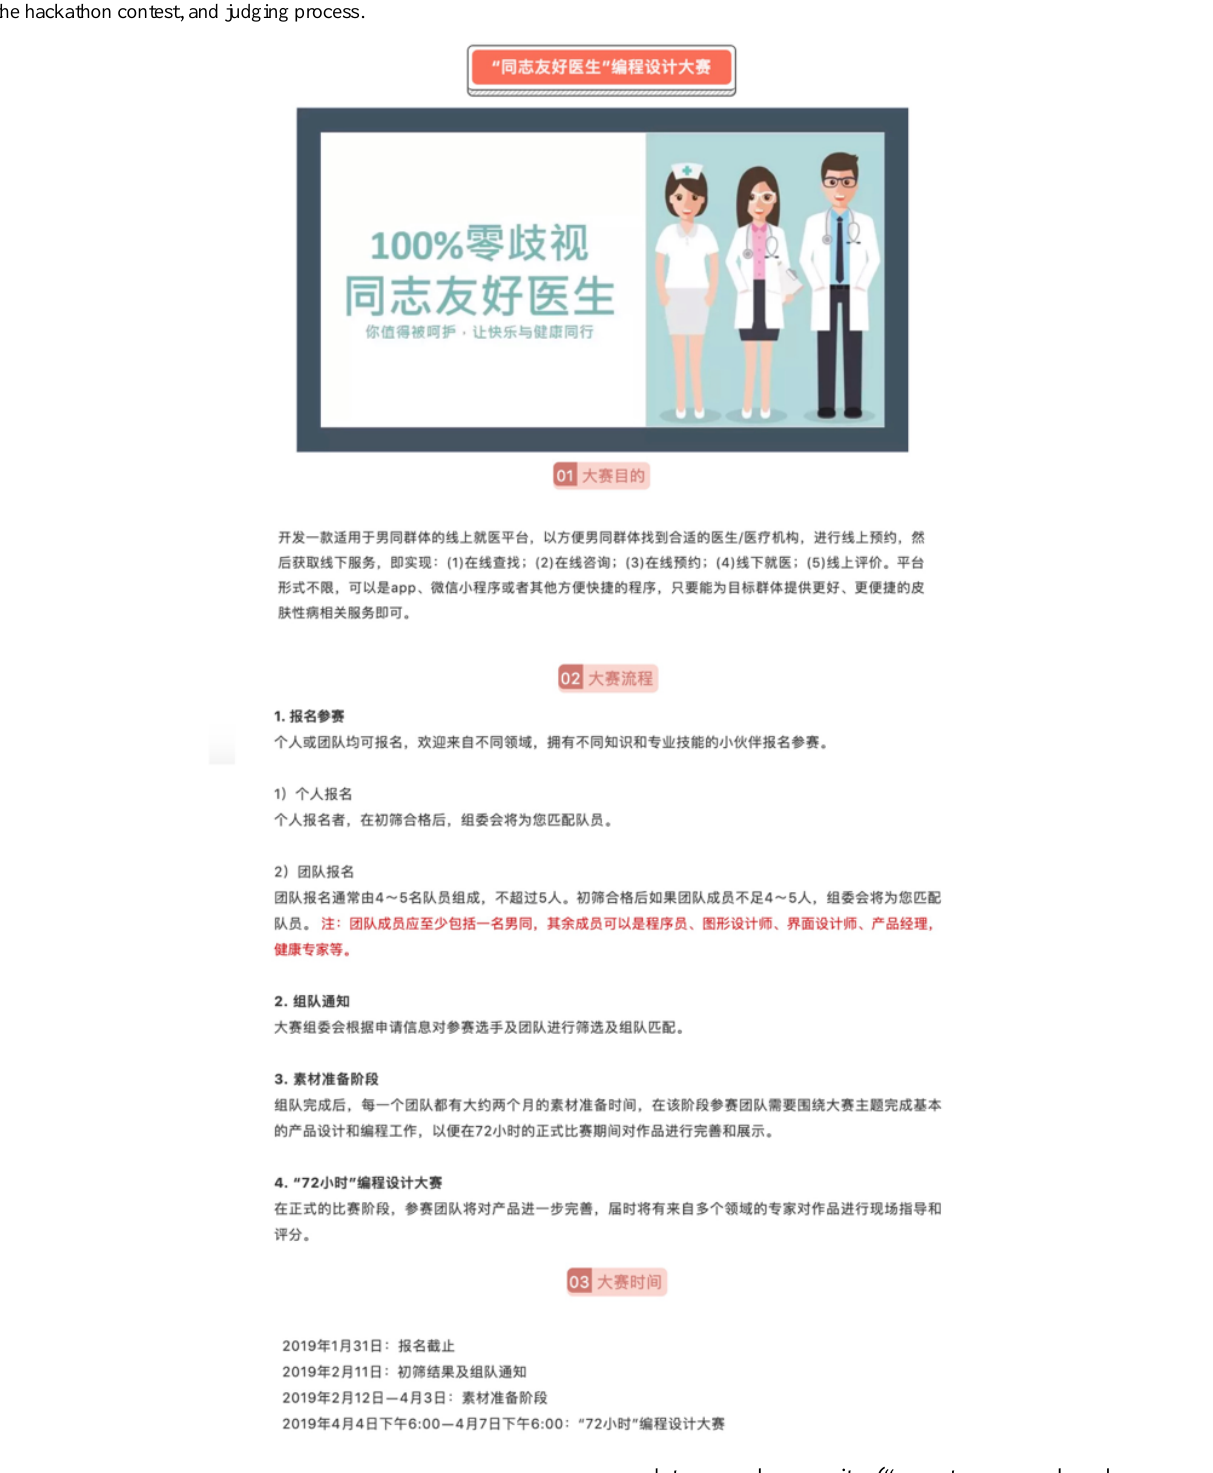
Figure 1. A screenshot of the call for applicants (advertised on Chinese social media). It introduced the health needs among men who have sex with men, expected functions of mobile health tools for enhancing health care utilization, procedure on how to apply, participants’eligibility criteria, timeline of the hackathon contest, and judging